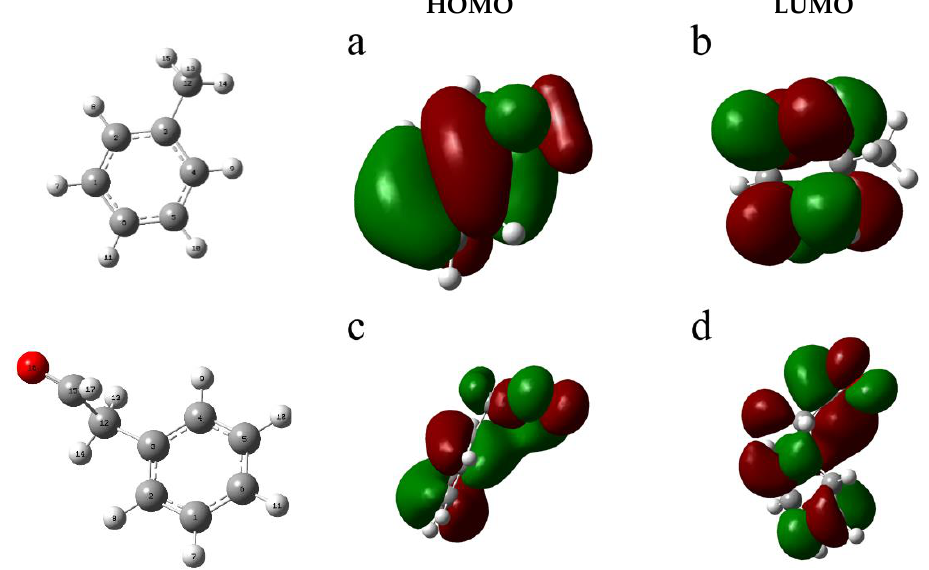
Figure 4. ( a ) CH3-HOMO, ( b ) CH3-LUMO, ( c ) CHO-HOMO, ( d )